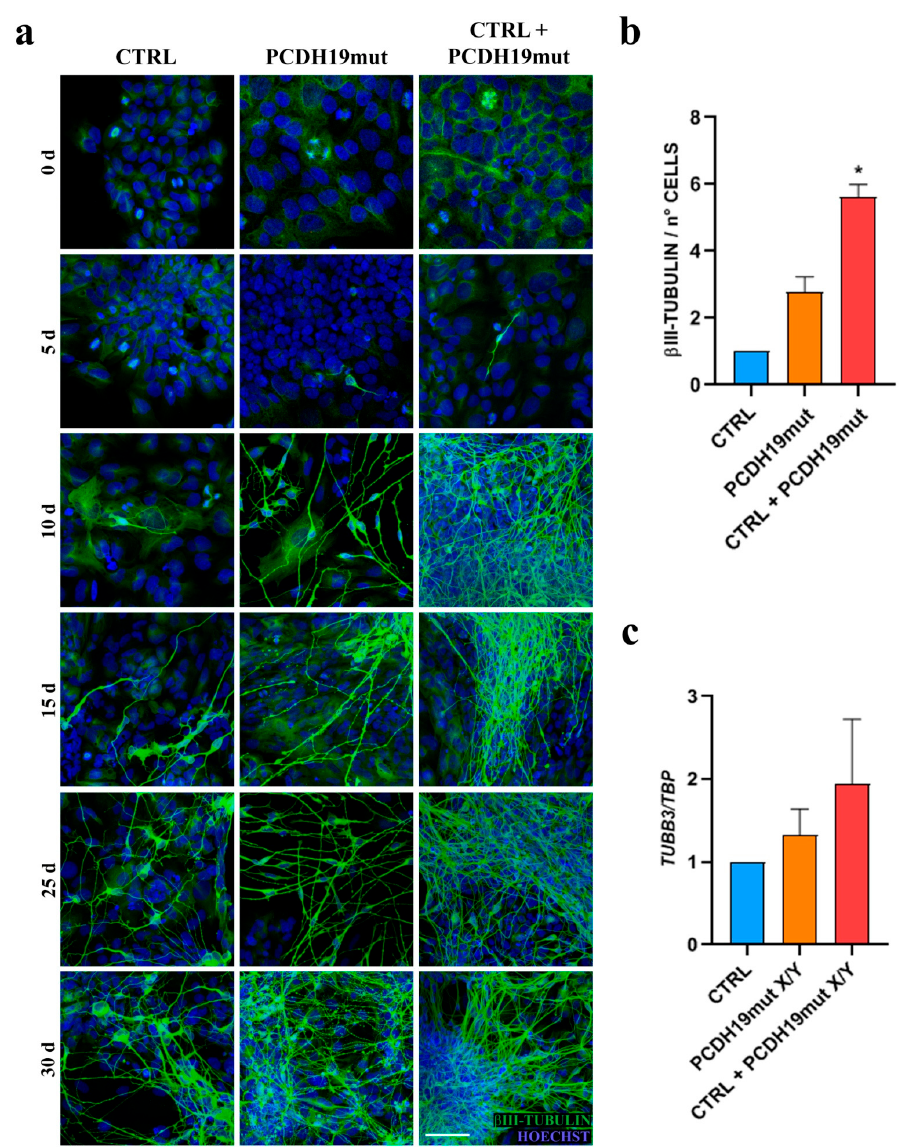
Figure 3. Neuronal differentiation of CTRL, PCDH19mut and mixed (CTRL + PCDH19mut) iPSC populations. ( a ) Micrographs of immunofluorescence assays for β III-tubulin at different in vitro cortical neurogenesis timepoints, showing an accelerated differentiation of PCDH19mut and mixed cultures compared to CTRL. Scale bar = 50 µ m; ( b ) Bar graph depicting the quantification of β III-tubulin signal on the 30th day of differentiation in cortical neurons. Data are normalized to control and presented as the mean ± SEM, three biological replicates are indicated as n = 3. * p < 0.05, according to Kruskal–Wallis test; ( c ) Bar graph showing RT-qPCR analyses for TUBB3 in PCDH19mut and mixed culture derived cortical neurons compared to CTRL cortical neurons. Data are presented as the mean ± SEM (normalized to control), n = 3. * p < 0.05, according to ordinary one-way ANOVA parametric